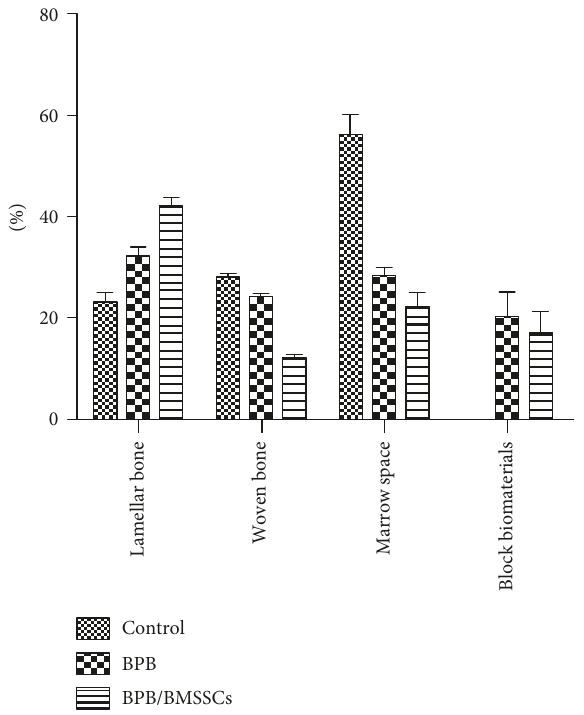
Figure 7: Percentage bar graphic showing di ff erence between site compositions in three groups: control, bone porcine block, and bone marrow stromal stem cells/bone porcine